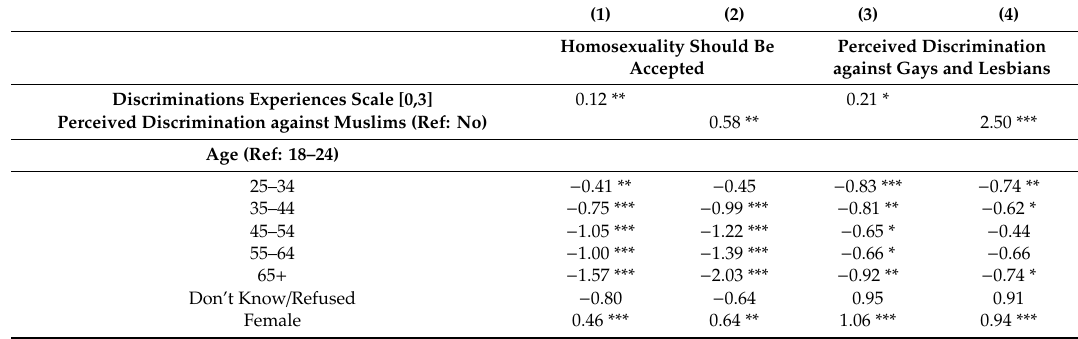
Table A5. Coe ffi cients from Logistic Regression Predicting Solidarity with Gays and Lesbians using Imputed